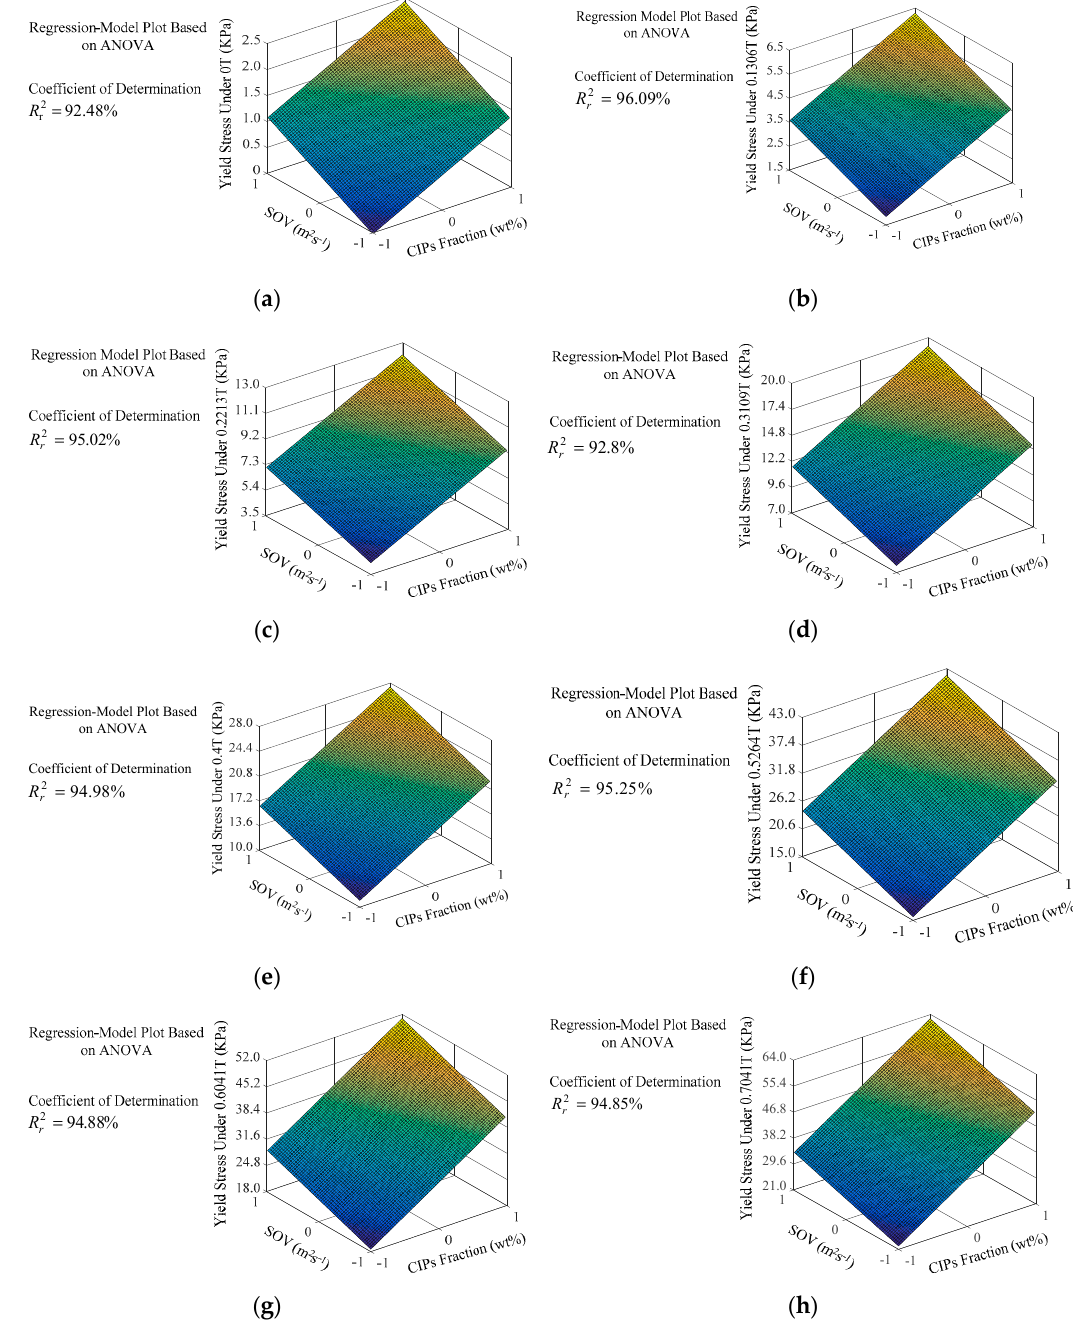
Figure 5. ( a ) Response surface analysis (RSA) of yield stress under a magnetic field of 0 T; ( b ) RSA of yield stress under a magnetic field of 0.1306 T; ( c ) RSA of yield stress under a magnetic field of 0.2213 T; ( d ) RSA of yield stress under a magnetic field of 0.3109 T; ( e ) RSA of yield stress under a magnetic field of 0.4 T; ( f ) RSA of yield stress under a magnetic field of 0.5264 T; ( g ) RSA of yield stress under a magnetic field of 0.6041 T; ( h ) RSA of yield stress under a magnetic field of 0.7041 T.